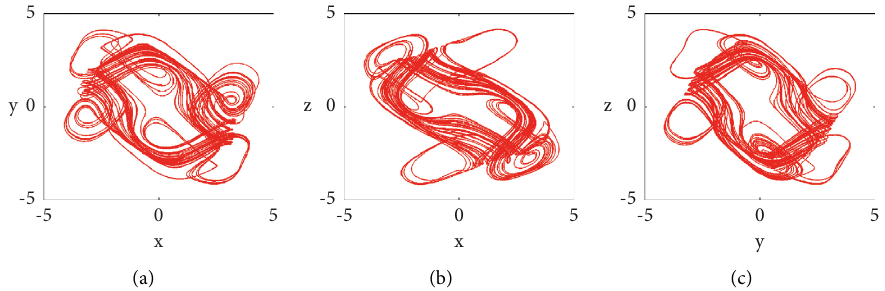
Figure 6: Chaotic attractor of system (4) when q ( x ,y ,z ) � (− 1 , 1 , 1 ) on (a) xy plane, (b) xz plane, and (c) yz 0 0 0